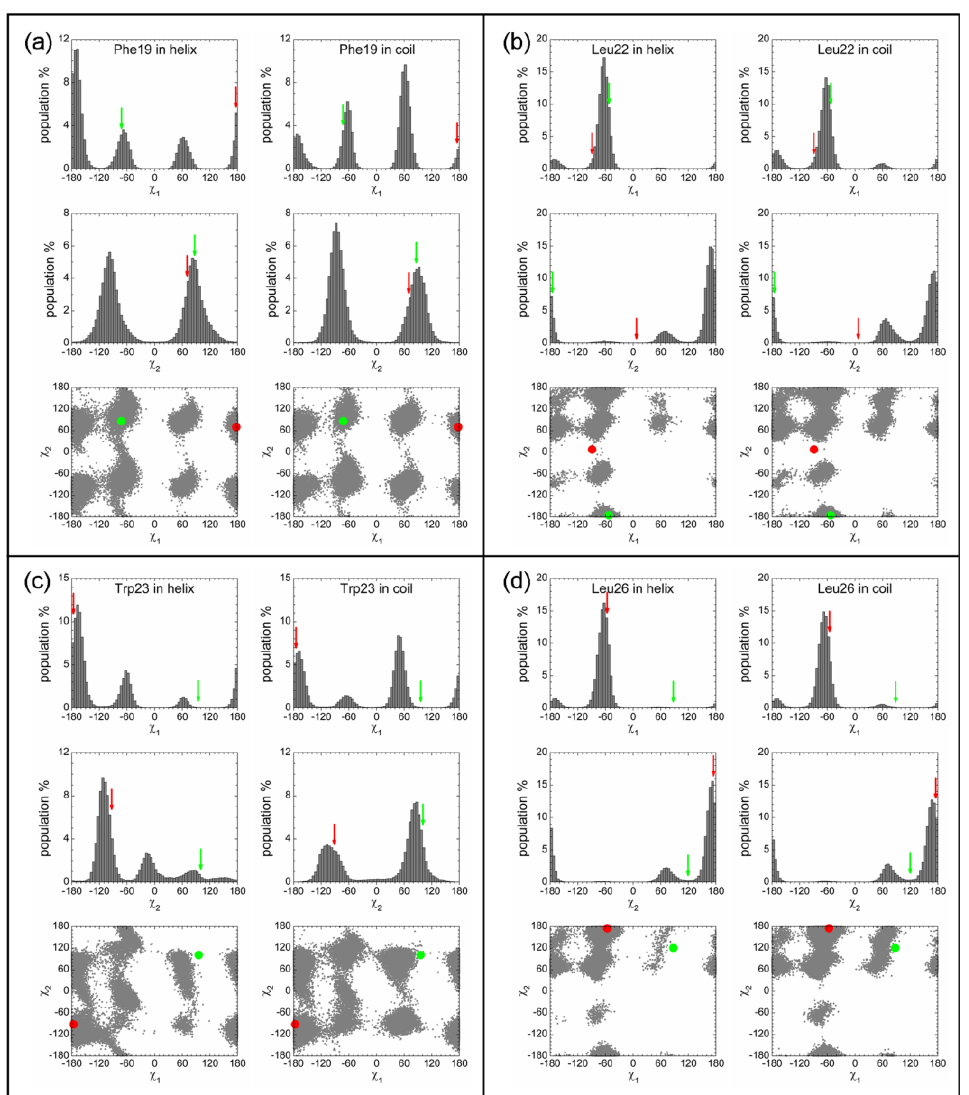
Figure 3. Conformational analysis of the anchor residues in the helix state and disordered state of the unbound p53N. The bound conformation values in the p53N-MDM2 and p53N-Taz2 complexes are denoted by red and green markers, respectively.